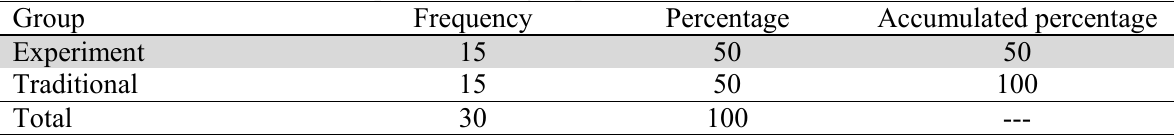
Distribution of the statistical sample based on group Group Frequency